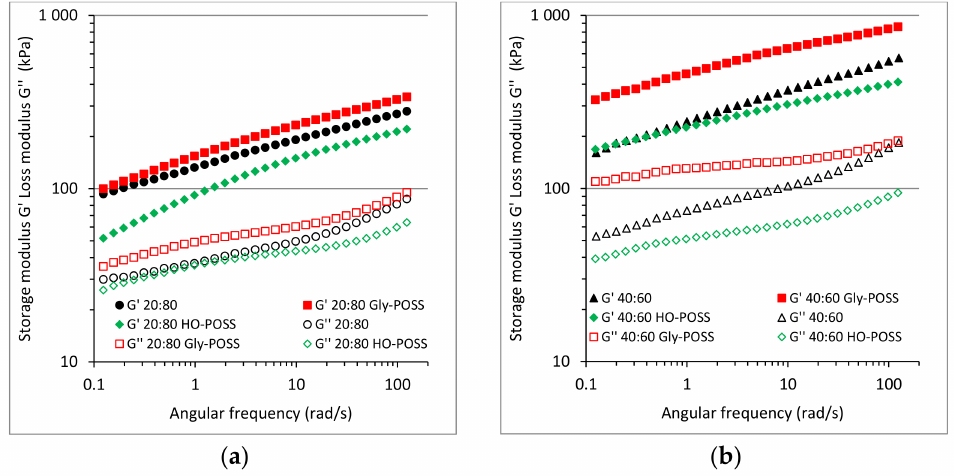
Figure 10. Influence of POSS on the storage shear modulus G’ and loss shear modulus G” as a function of angular frequency at 30 ◦ C for 20:80 PLA/ENR ( a ) and 40:60 PLA/ENR ( b )